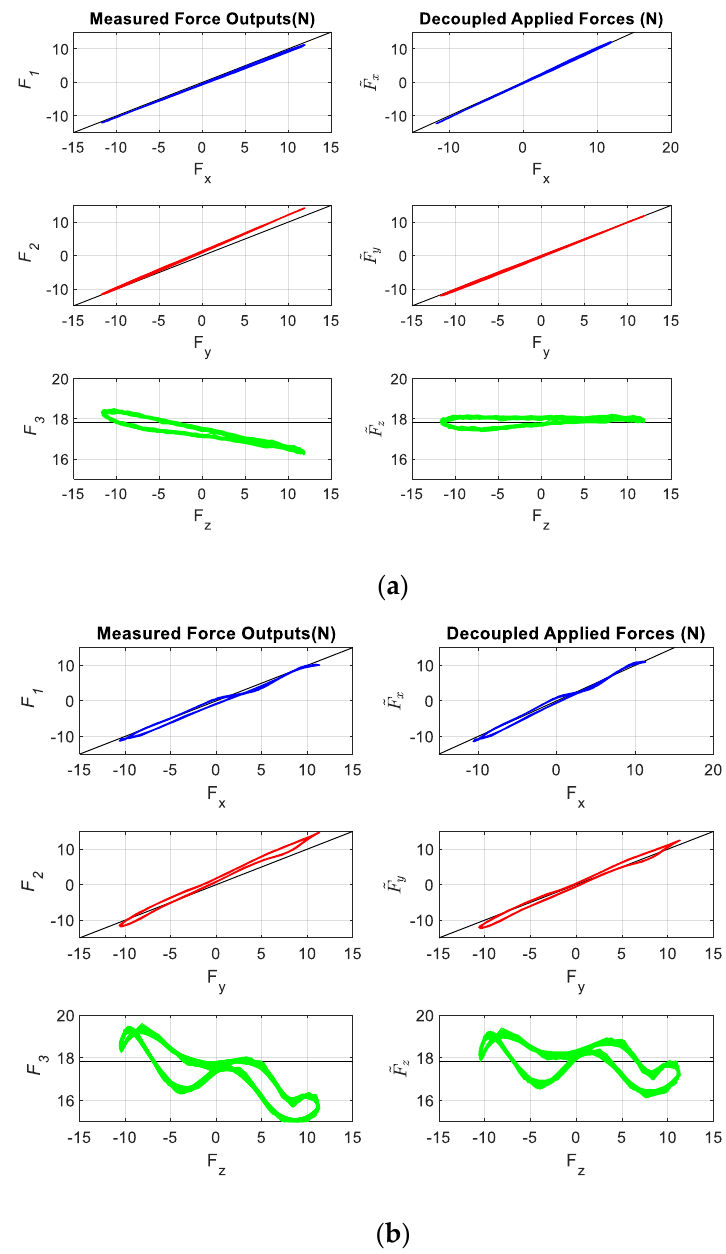
Figure 11. Decoupling method applied in dynamic loading experiment at ( a ) 100 Hz and ( b ) 200 Hz.